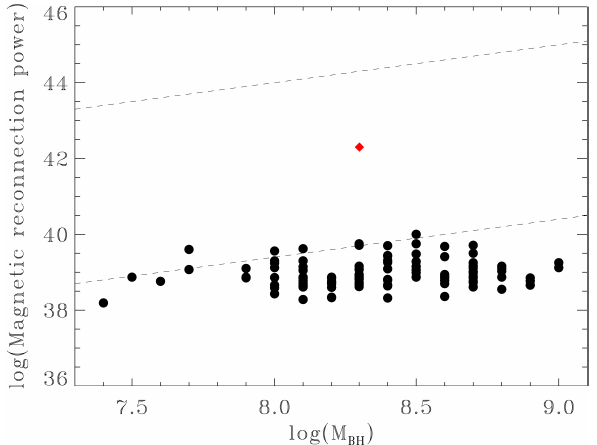
Figure 6. Turbulent driven magnetic reconnection power (erg s − 1 ) against BH masses (M (cid:12) ) compared to the observed radio emission from FIRST catalogue for the 104 FR 0s from the FR0 CAT (black points). For Tol 1326-379, we also plot the high-energy ( > 1 GeV) luminosity (red diamond). The region enclosed between the two dashed lines represents the maximum range of magnetic reconnection power predicted for RGs for supermassive BHs with different internal conditions (see